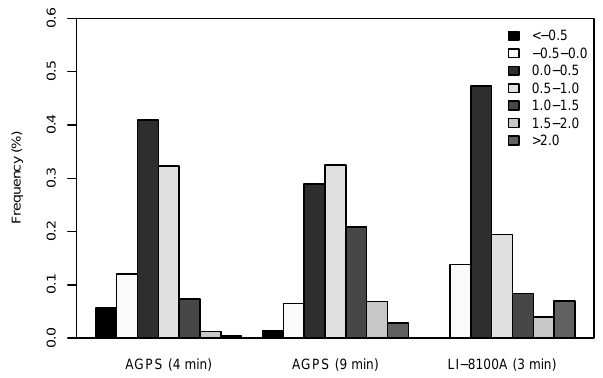
Figure 3. Air temperature change inside the chambers during the closure time. For the AGPS, temperature change is shown for the first 4min of the closure time and for 9min closure time. The LI- 8100A had a closure time of